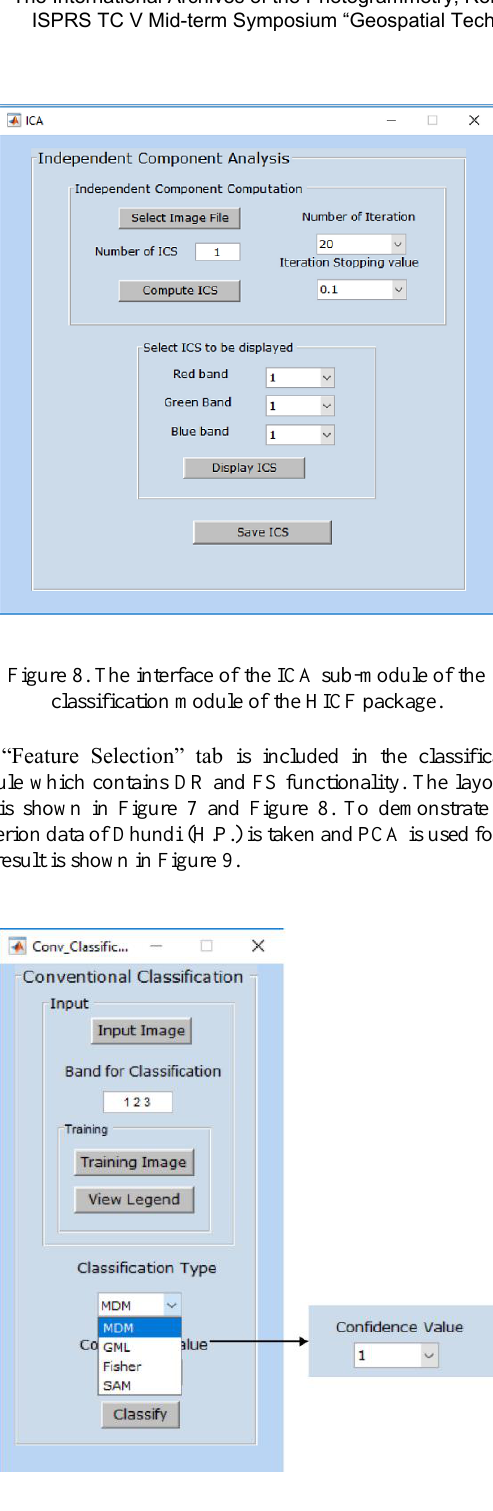
Figure 10. Interface for the conventional methods in the classification module of the HICF package.